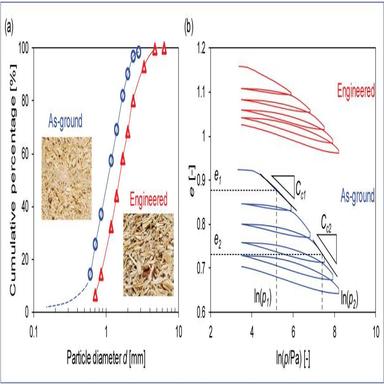
(a) The particle size distribution of two investigated samples with the corresponding photographs demonstrating particle morphology. The blue dashed line is extrapolated due to the limitation of the particle size characterization using the sieving method. (b) Semi-logarithmic relation between void ratio e and mean stress p of the two samples as measured using oedometer tests. Three replicate oedometer tests were performed for each sample, then hs and n were calculated from Eq. 3 and averaged. Moreover, diff